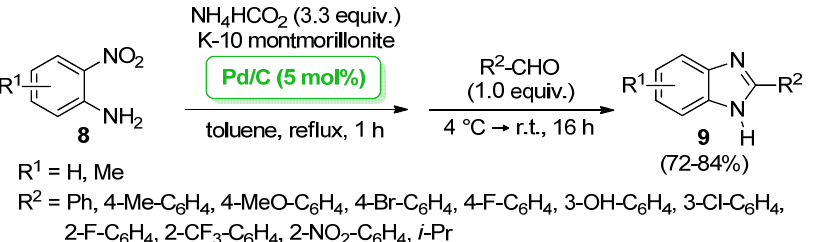
Scheme 3. Synthesis of benzimidazoles 9 from ortho -nitroanilines 8 by tandem transfer hydrogena- tion/condensation/dehydrogenation catalyzed by Pd/C, reported in 2012 by Magolan et al.